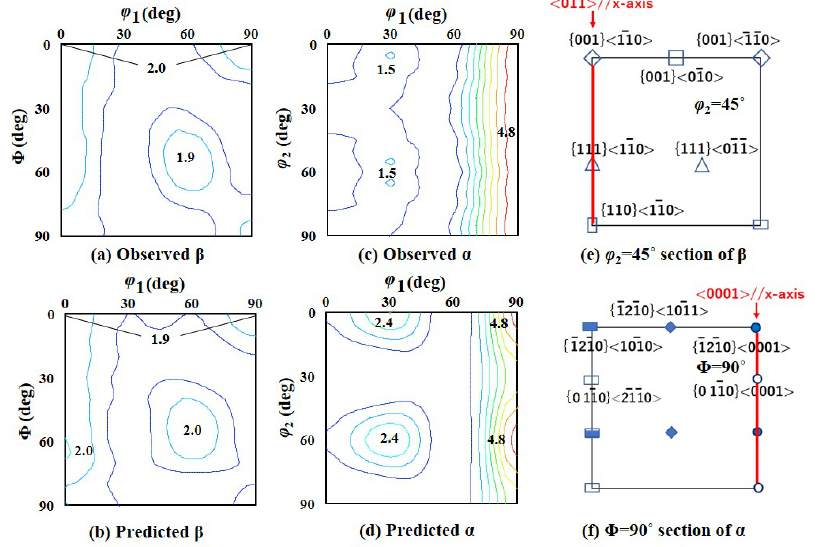
Figure 16. ODF sections of ( a , c ) observed textures of ( a ) β at 1050 ◦ C and ( c ) final α at 900 ◦ C and ( b , d ) predicted textures of ( b ) β and ( d ) final α . ( e , f ) Important orientations. Contour levels are 1, 1.5, 2,